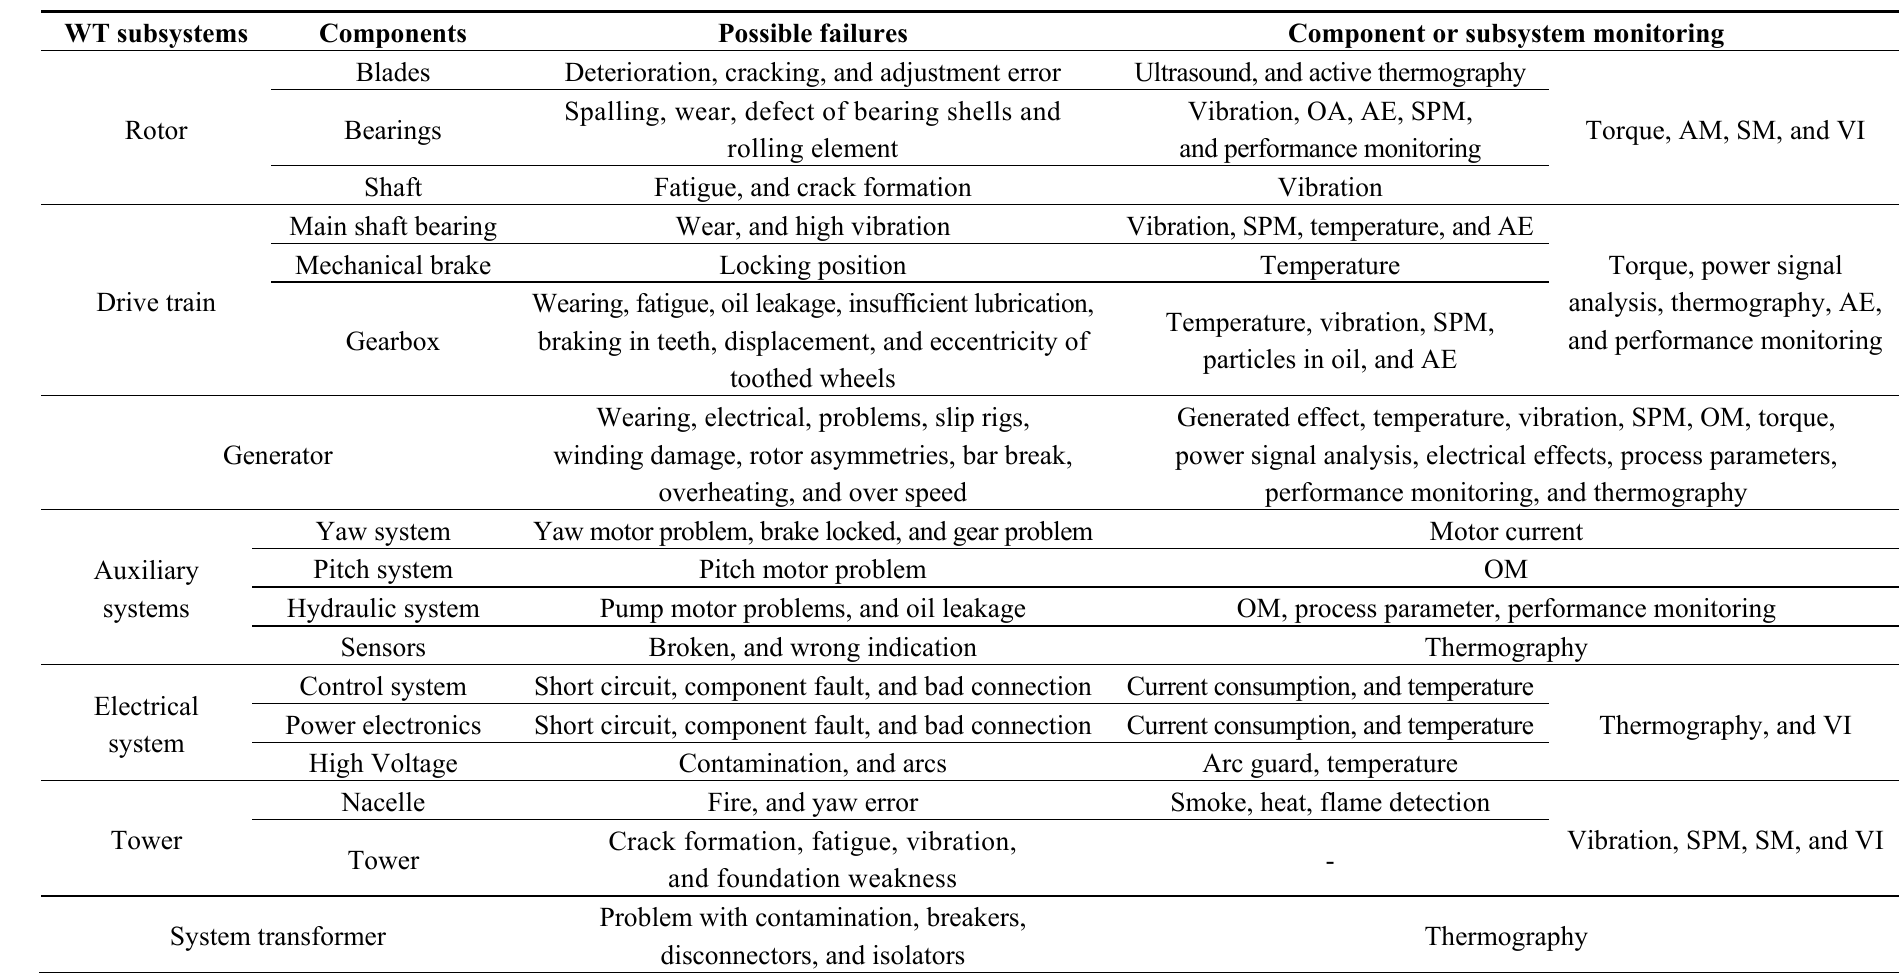
Table 1. Overview of possible failures and monitoring techniques for various WTs components and subsystems. OA: oil analysis; AE: acoustic emission; SM: strain measurement; VI: visual inspection; SPM: shock pulse method; and OM: operation and